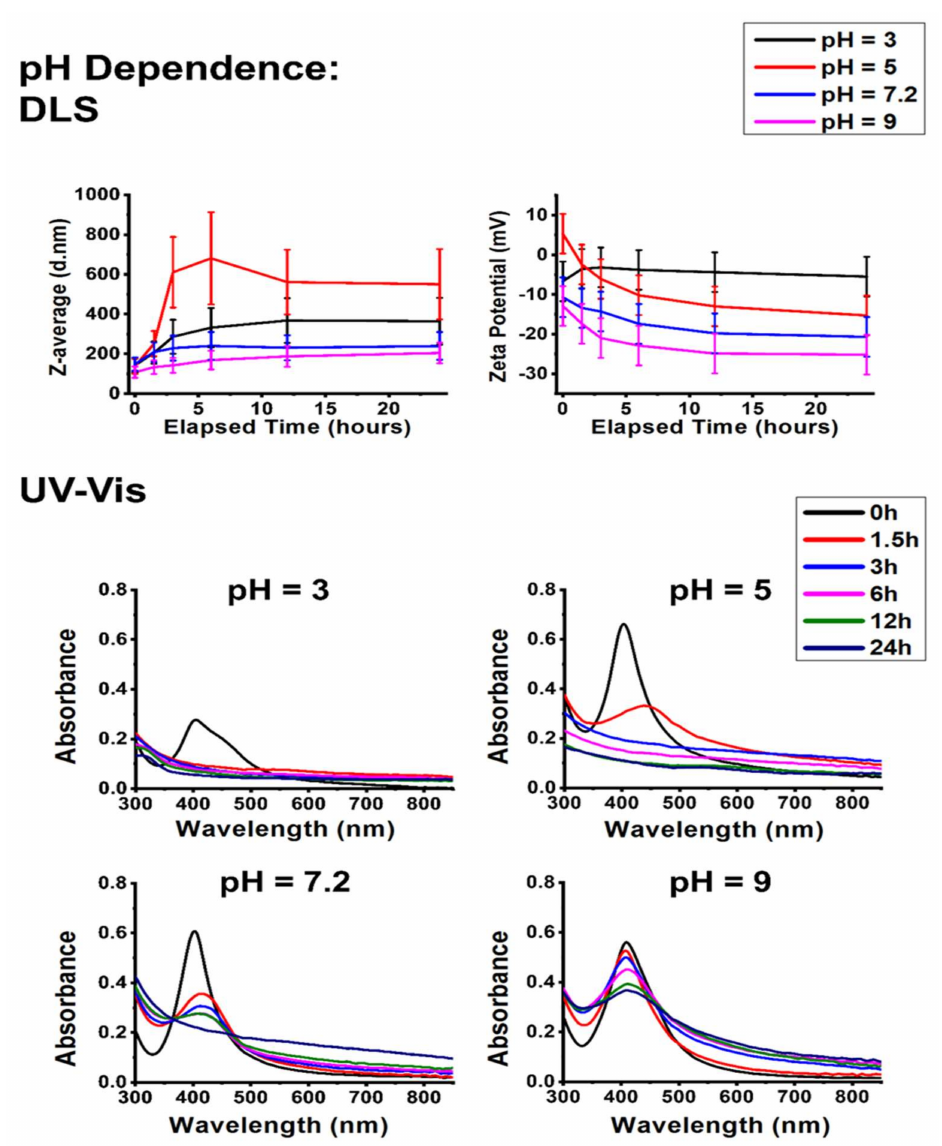
Figure 3. The effect of pH on the aggregation behavior of PVP-stabilized silver nanoparticles. Dynamic light scattering (DLS) results (top) are represented as average hydrodynamic diameter (Z-average) and zeta potential changes; UV–Vis absorbance spectra (bottom) of PVP-stabilized silver nanoparticles taken over 24 h under various pH